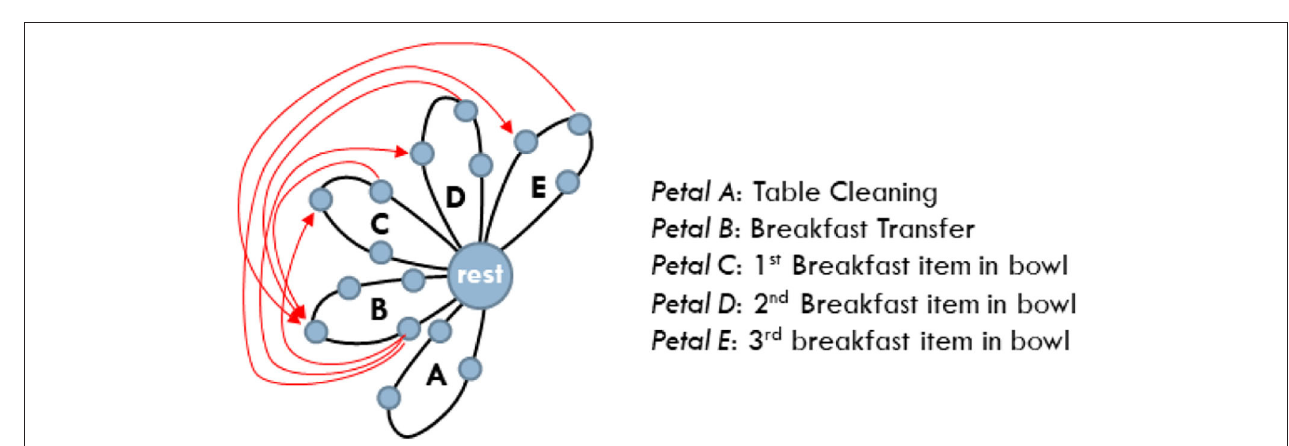
FIGURE 8 | The daisy representation of the tasks involved in the timely breakfast delivery scenario. Constraints among actions are depicted in red.